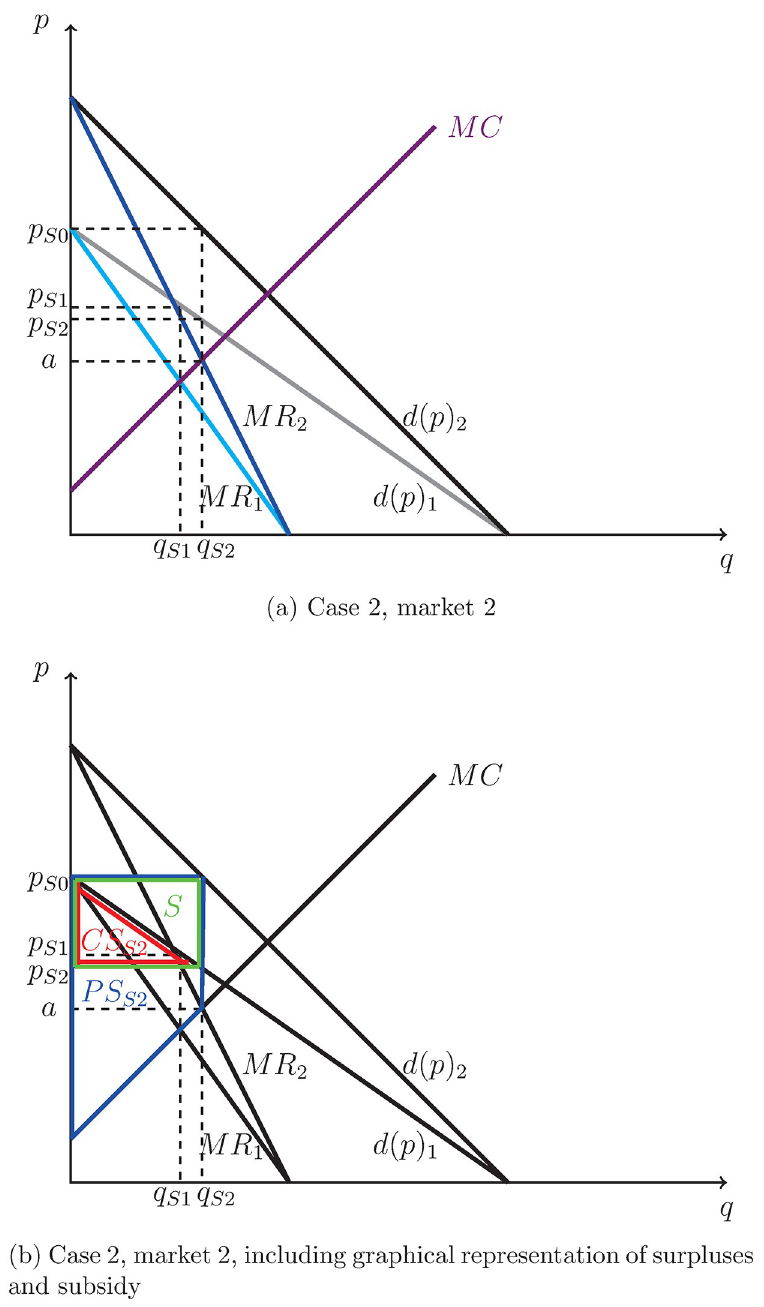
Fig 4. Case 2, market 2: Monopoly with increasing marginal cost and subsidy. (a) Case 2, market 2. (b) Case 2, market 2, including graphical representation of surpluses and subsidy.